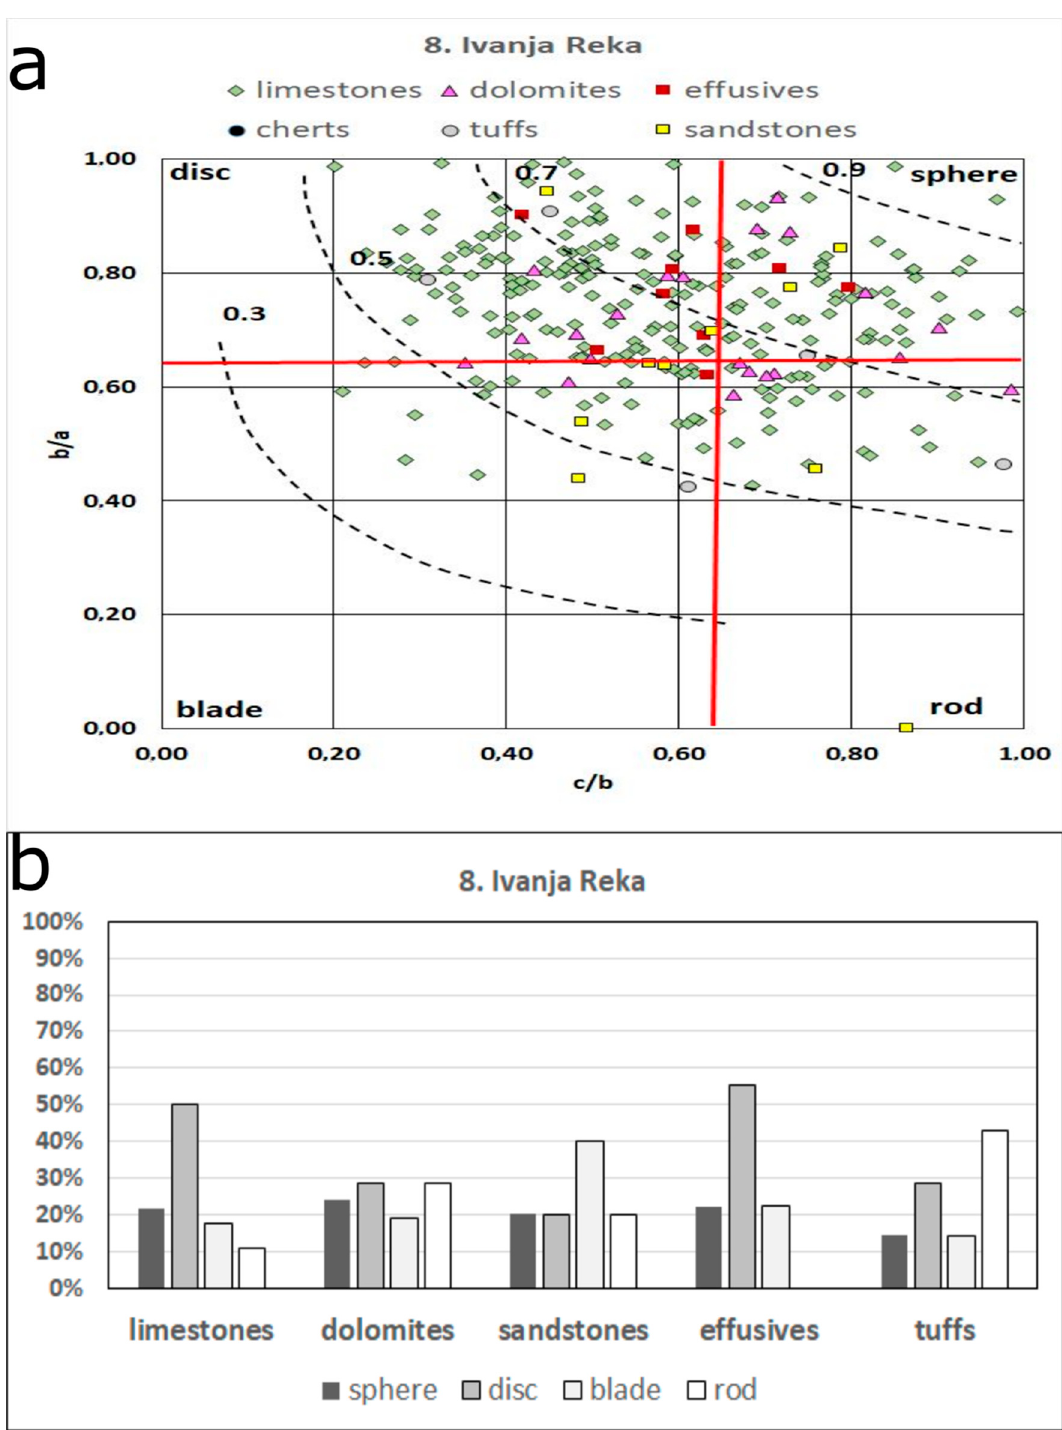
Figure 14. Pebble shapes of main lithotypes in Ivanja Reka: ( a ) Zingg diagram; ( b ) histograms.